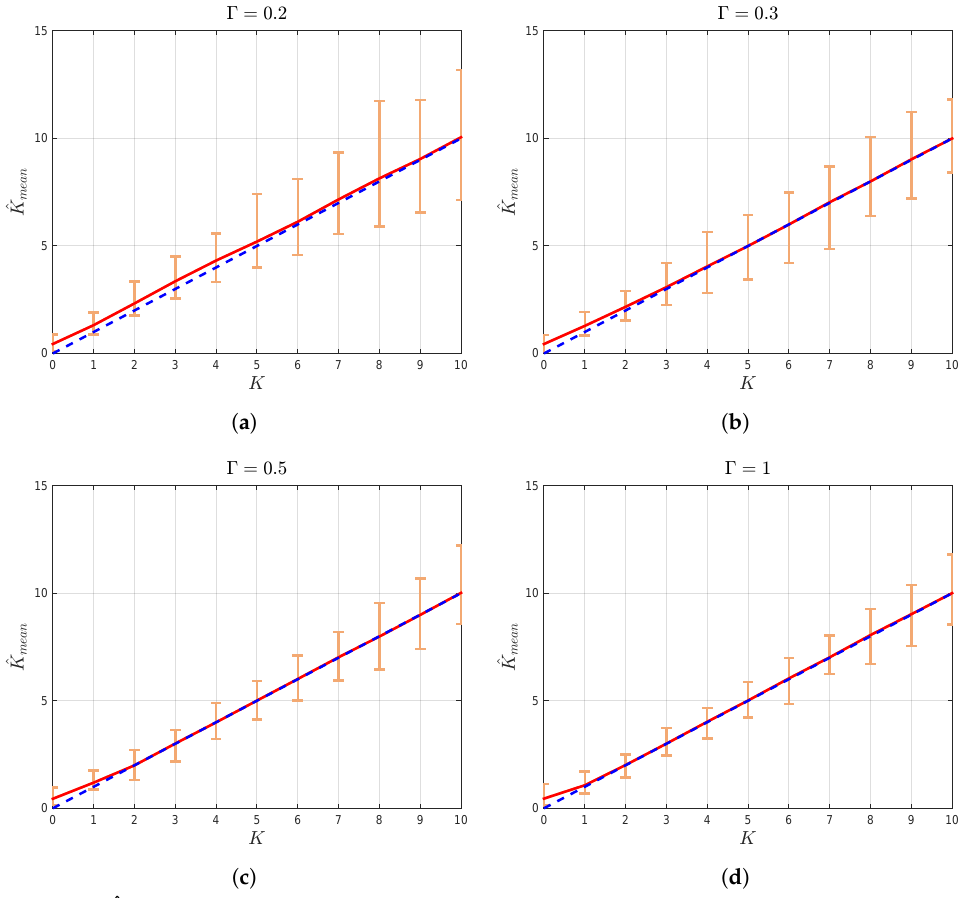
Figure 2. ˆ K mean (with absolute error bars) vs. K for ( a ) Γ = 0.2, ( b ) Γ = 0.3, ( c ) Γ = 0.5, and ( d ) Γ = 1. The solid line shows a linear regression fit to the data. Unit slope dashed line is illustrated as a benchmark.